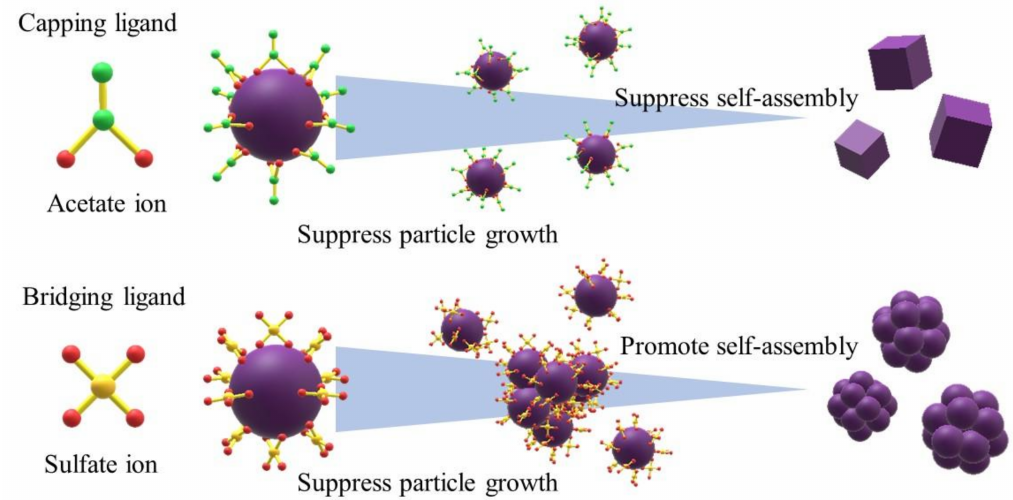
Figure 1. Schematic illustration of the strategy used to synthesize a complex 3D nanostructure using bridging